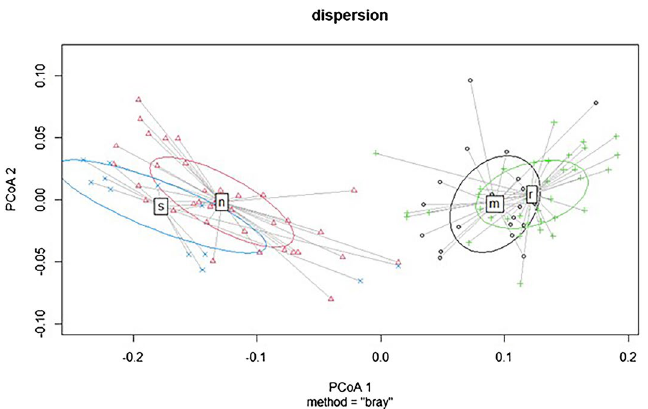
Figure 5. A significant differentiation of target forest types based on various combinations of optical bands extracted from Sentinel-2 data (obtained on May 13, 2018), where the P value is less than 0.001. Abbreviations: